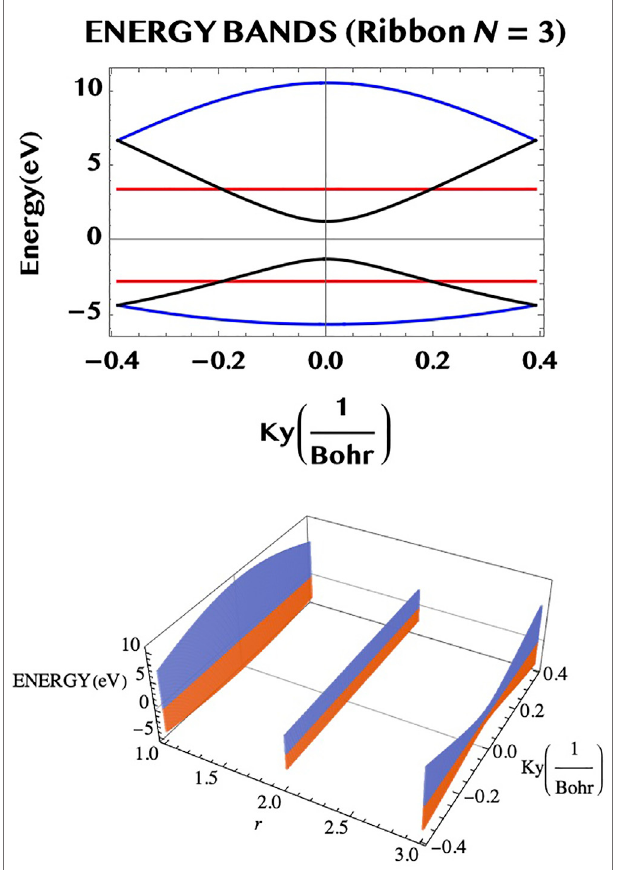
FIGURE 5 | The dispersion relation of the N = 3 armchair ribbon (upper part) may be seen from a different perspective (lower part) as consisting of three “ channels ” of VB – CB pairs (along the armchair axis), separated by unit widths in the transverse direction.